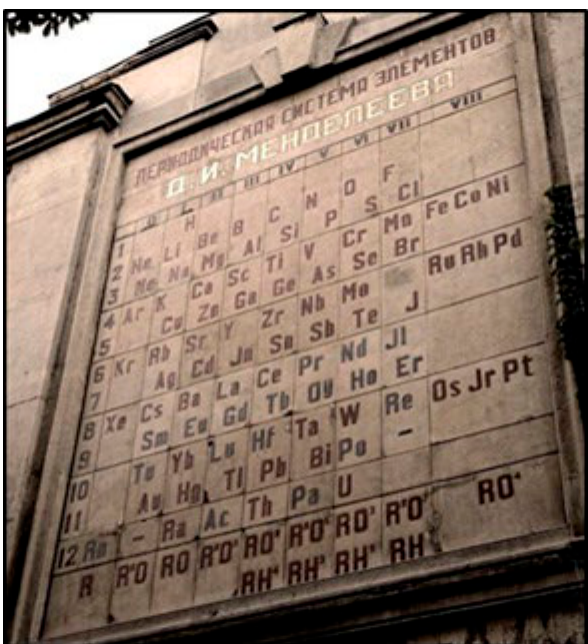
Figure 16. Periodic Table on a Wall. Saint Petersburg,